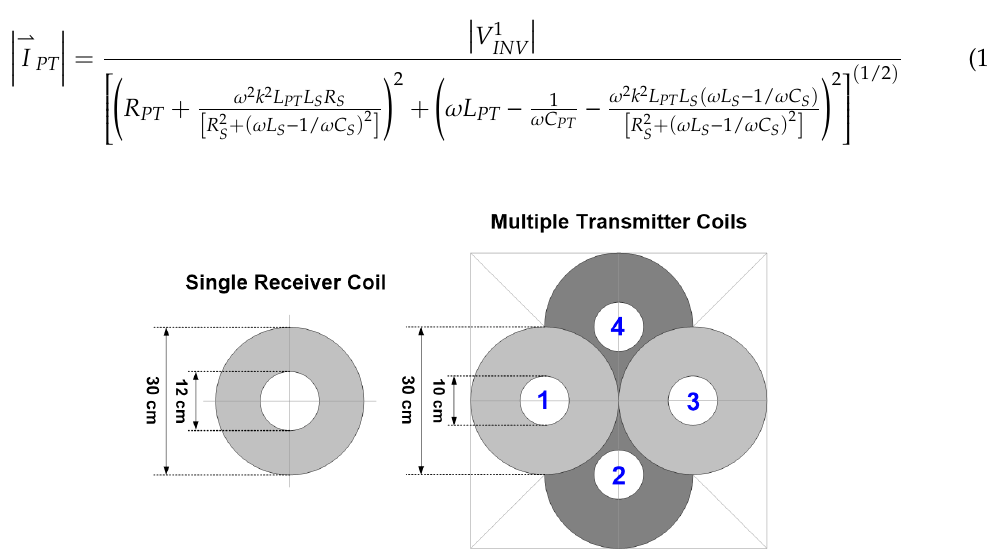
Figure 9. Coupled coil arrangement.